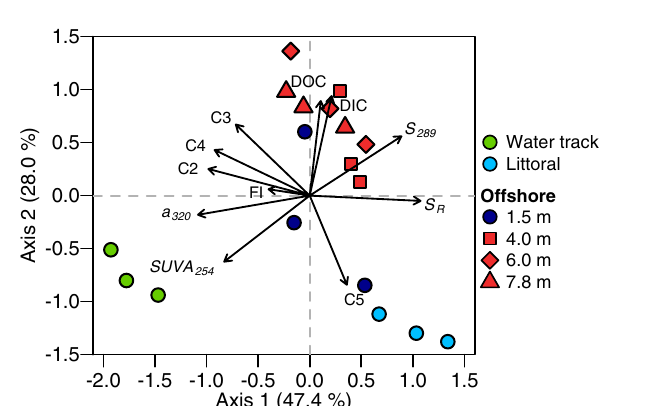
Figure 5. Spectral absorption by the optically active constituents in Ward Hunt Lake. The total absorption coefficients are partitioned according to: phytoplankton ( a ph ), non-algal particulates ( a NAP ), colored dissolved organic matter ( a CDOM ) and water molecules ( a w ). For comparison with four depths at the midlake station, data are also shown for surface waters of the littoral zone sampled on the same day.